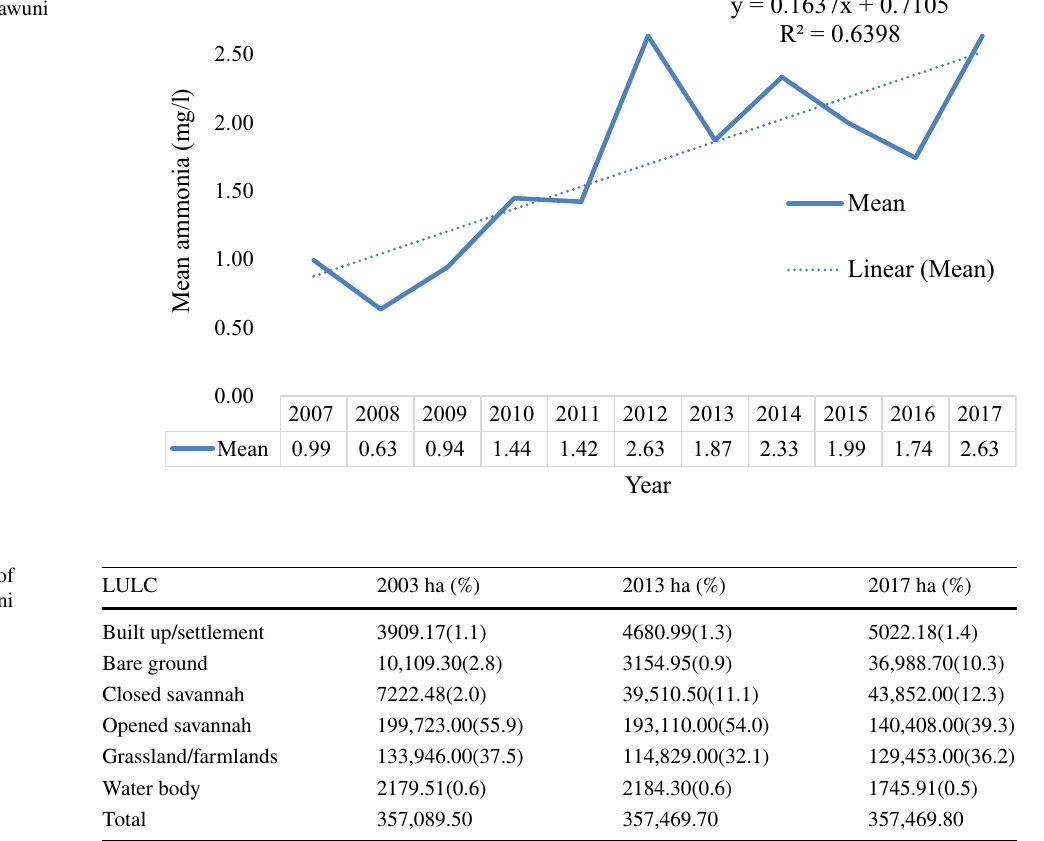
NB: Values in parentheses are